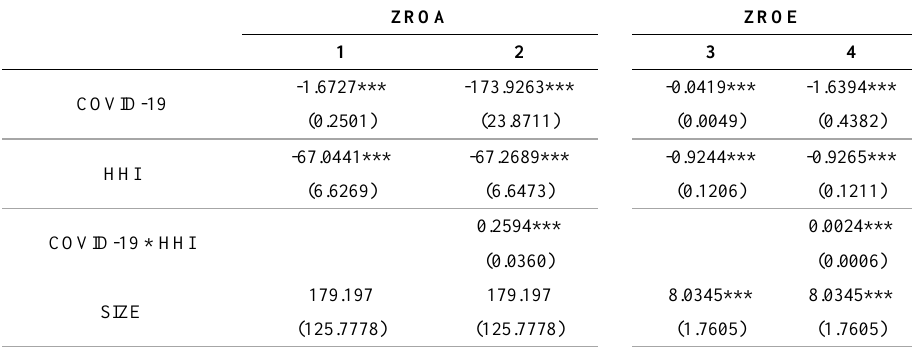
Table 3. The Impact of COVID-19 and Bank Concentration on Bank Stability;